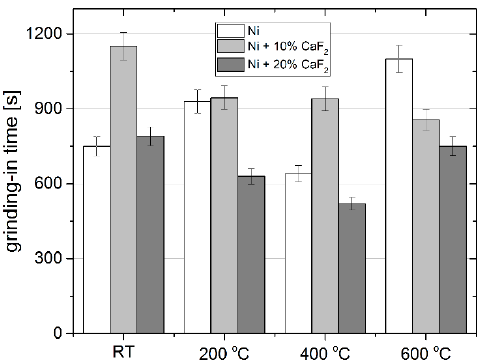
Figure 16. The grinding-in times for sintered Ni, Ni-10% CaF 2 and Ni-20% CaF 2 self-lubricating composites after wear test at different temperatures.